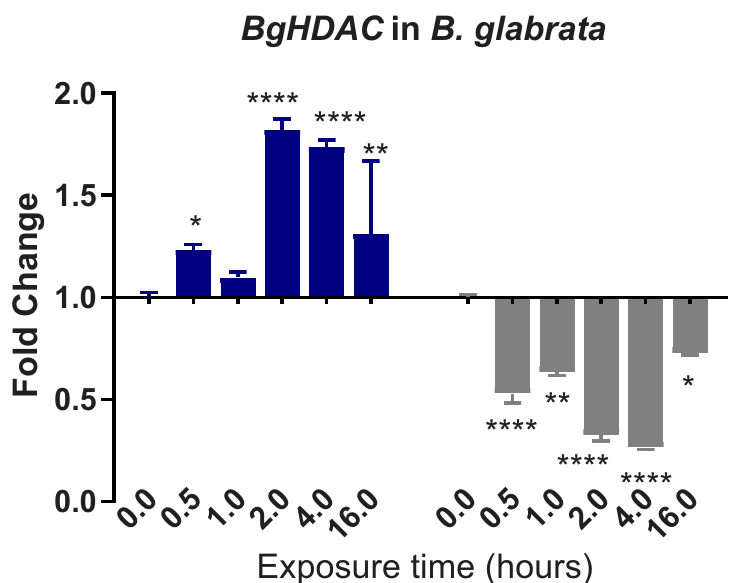
Fig 2. qPCR analysis of RNA from either resistant BS-90 (blue histogram) or susceptible BBO2 (gray histograms) juvenile snails unexposed (0) or exposed for increasing intervals (30 seconds to 16 hours) to S . mansoni miracidia. Histograms show expression of the BgHDAC encoding transcript in snails at each time point from five biological replicates. Note the increase in fold change in the resistant BS-90 compared to the susceptible BBO2 snails after parasite infection. Significant expression normalized against expression of the myoglobin encoding transcript was measured by 2-way ANOVA and is indicated by number of asterisks on each histogram where ���� , indicates the most significant value p � 0.0001, ��� p � 0.001, �� p � 0.01, � p � 0.05, ns p > 0.05.